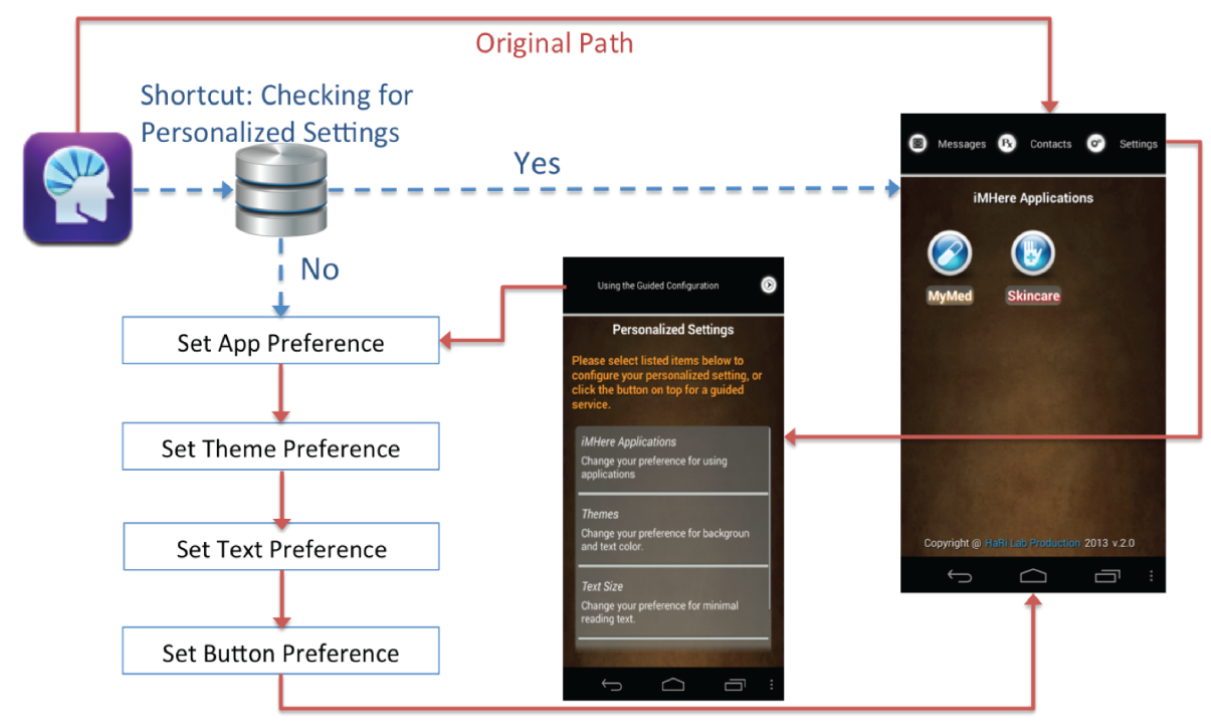
Figure 4. Navigation for personalized